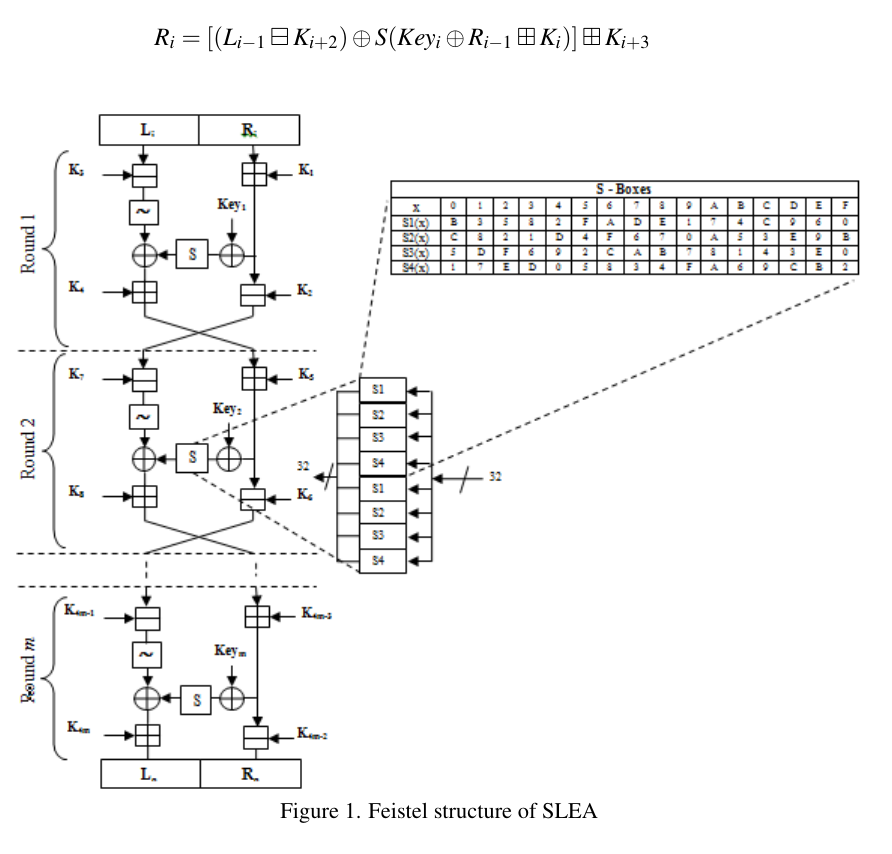
Figure 1. Feistel structure of